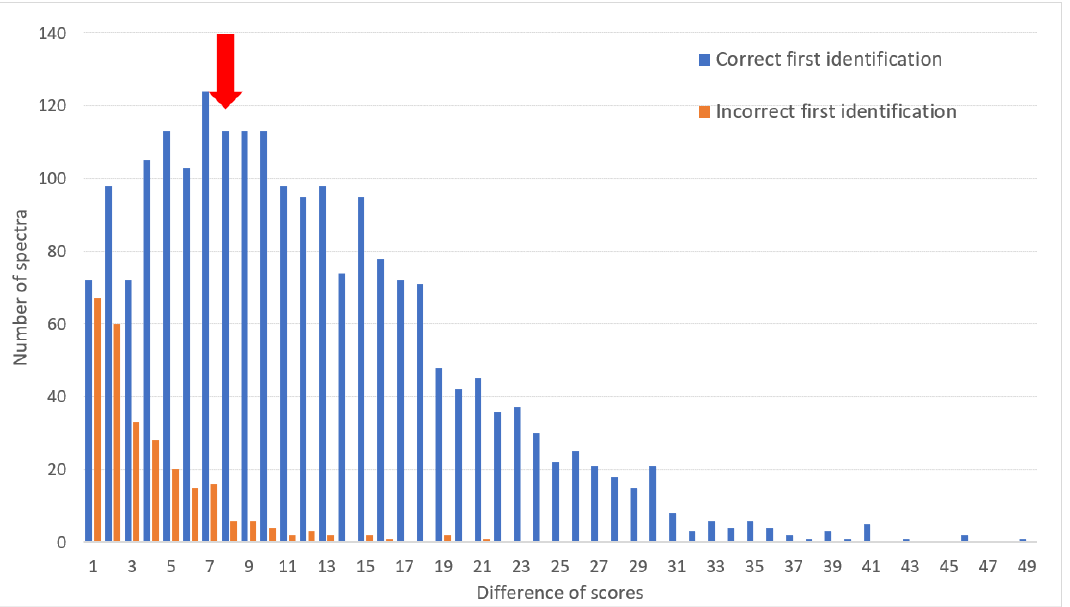
Figure 2. Difference between the score of the first identification and that of the second depending on whether the first identification was correct (results of identification with the L9 library and for the T. rubrum complex, T. interdigitale/T. mentagrophytes and T. equinum/T. tonsurans complexes). The red arrow indicates the chosen threshold (8) beyond which the identification result could be considered at the species level and below which it should be taken into account only at the complex level.